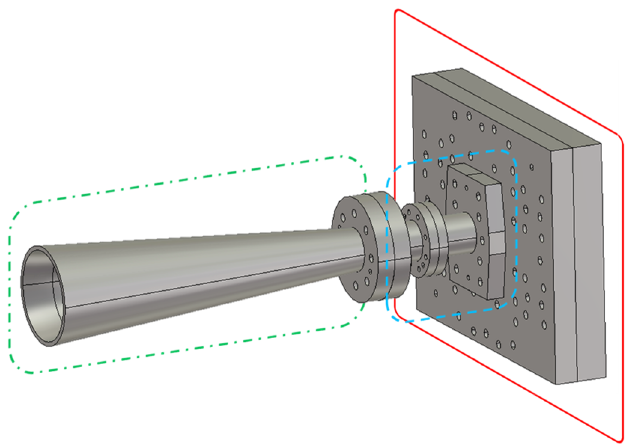
Figure 1. Monopulse horn antenna [22]. The three components that form the antenna are highlighted by different colors: solid red for the comparator network; dashed blue for the mode converter; and dashed-dotted green for the horn.